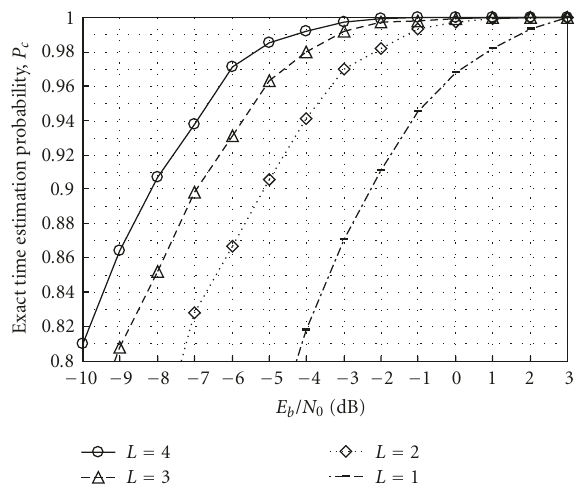
Figure 2: Symbol-timing acquisition probability of the proposed ranging